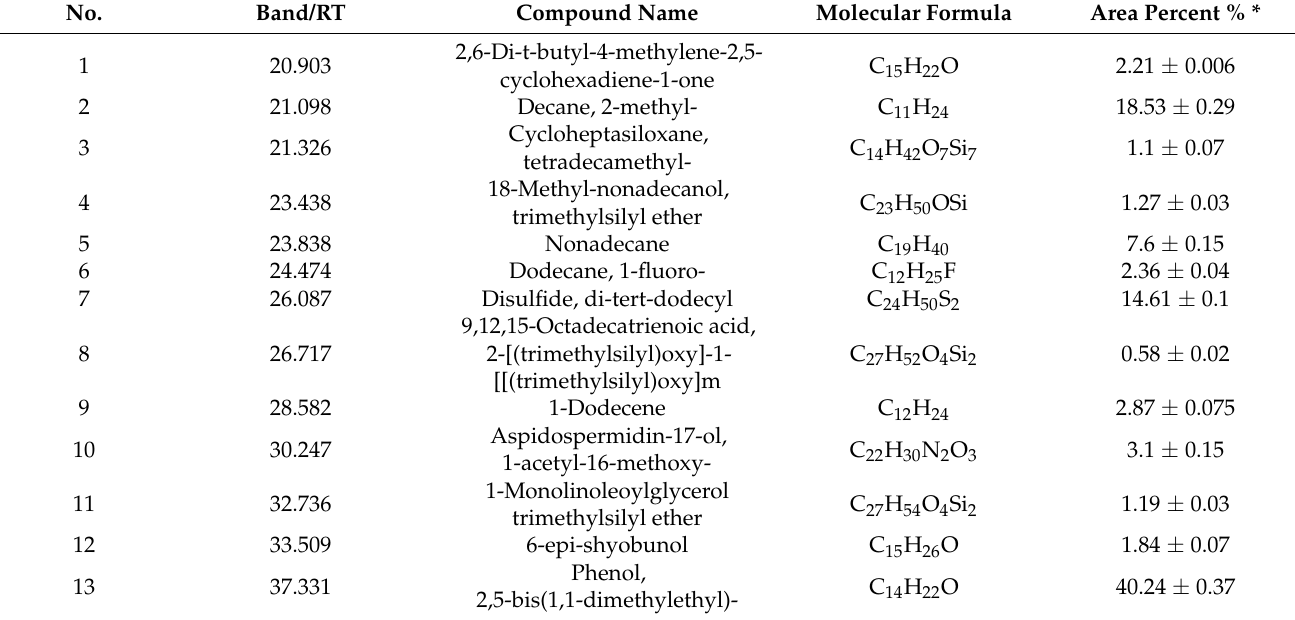
Table 2. Phytochemical components in methanolic leaves extract of Z. spina-christi identified by GC-MS